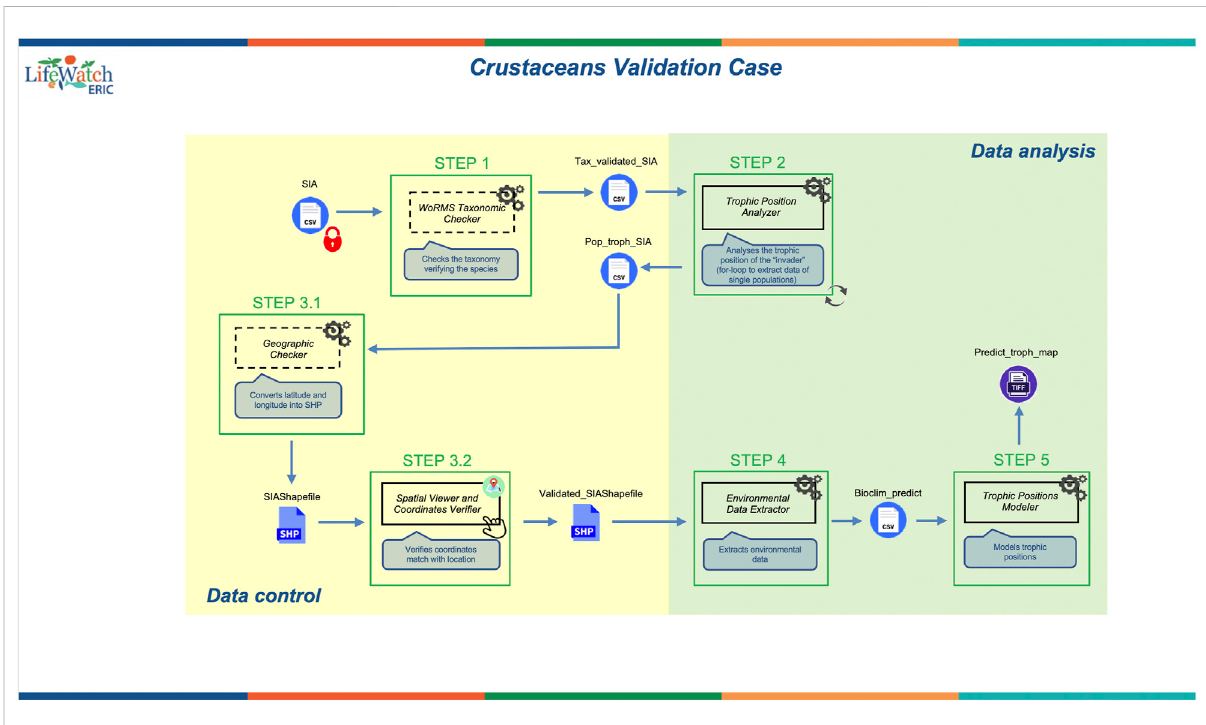
FIGURE 2 Crustacean Validation Case diagram. The diagram shows the analytical work fl ow and its components including services (steps in green boxes) and input/output datasets produced. A detailed guide to the symbols included in the diagram is provided in the Supplementary Material “ Work fl ow Standard – Guidelines ”